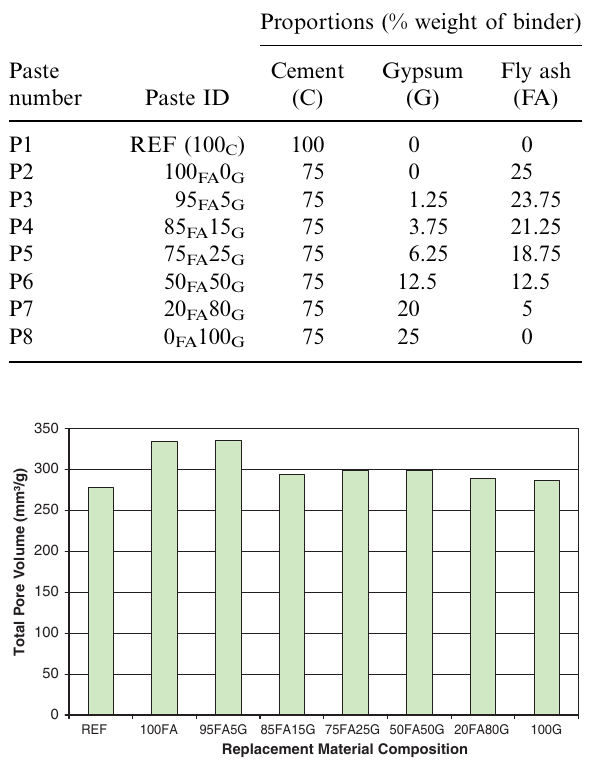
Fig. 1. Influence of FA-G composition on the TPV of